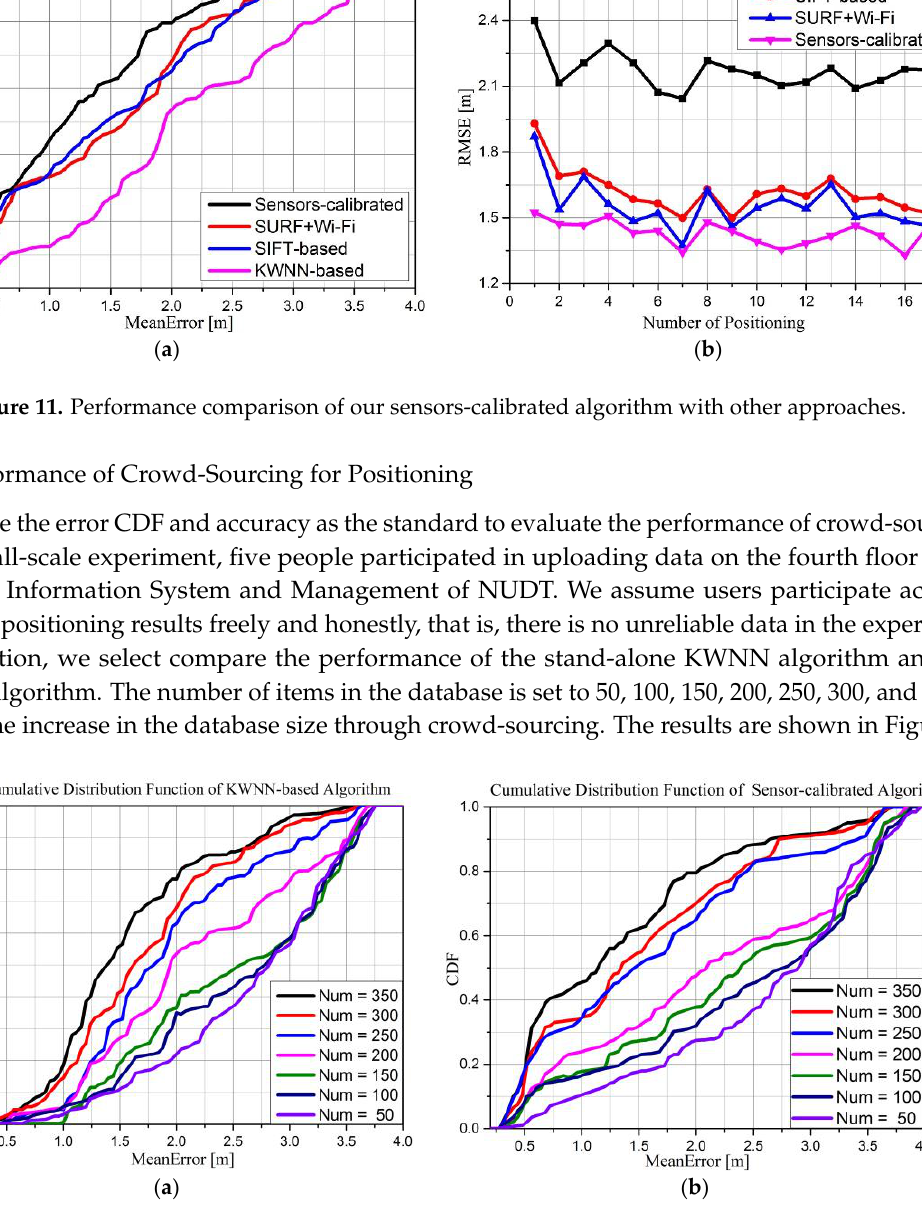
Figure 12. Performance comparison of crowd-sourcing.